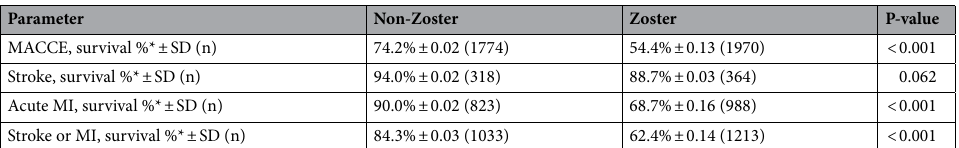
Table 2. Post zoster vascular event survival, throughout the entire study period. *Multivariable regression is adjusted to gender, age, diabetes, hypertension, socioeconomic status, dyslipidemia, and prior AMI.